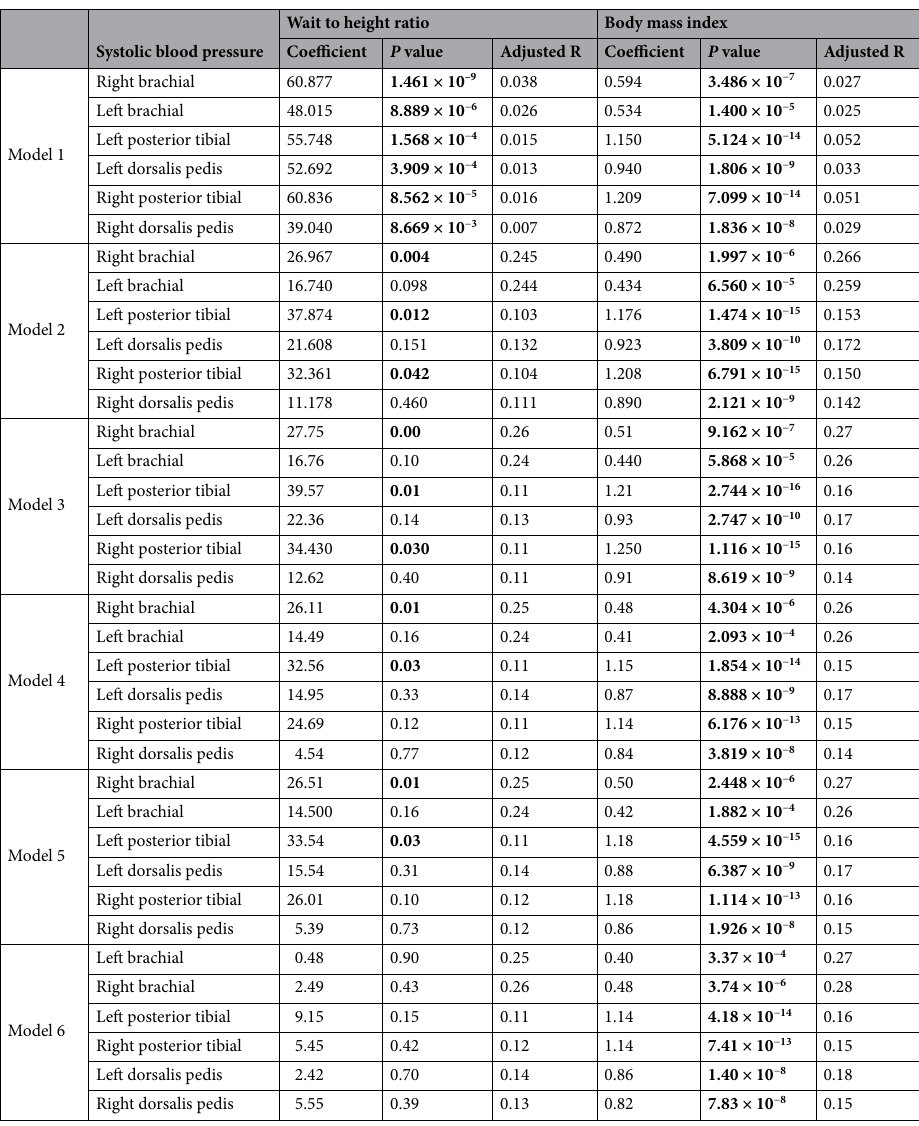
Table 2. Linear regressions comparing the individual systolic blood pressures with the waist to height ratio and the body mass index. Model 1: univariate analysis. Model 2: adjusted for sex, age, and ethnicity. Model 3: adjusted for sex, age, ethnicity, CVD. Model 4: adjusted for sex, age, ethnicity, T2DM. Model 5: adjusted for sex, age, ethnicity, CVD, T2DM. Model 6: adjusted for age, sex, ethnicity, cardiovascular diseases, and Type 2 diabetes, and hypertension treatments. Bold text: statistical significance using a P value < 0.05. CVD: cardiovascular disease; T2DM: type 2 diabetes